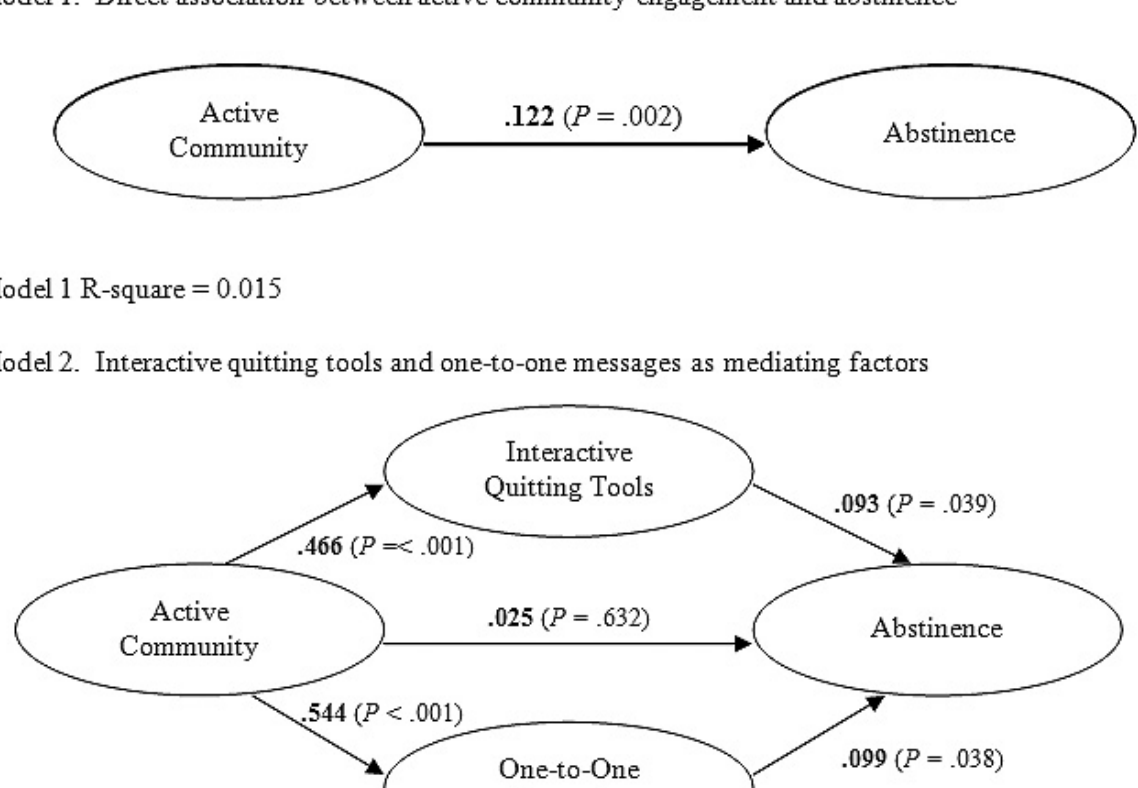
Figure 1. Path analysis of active community engagement and abstinence